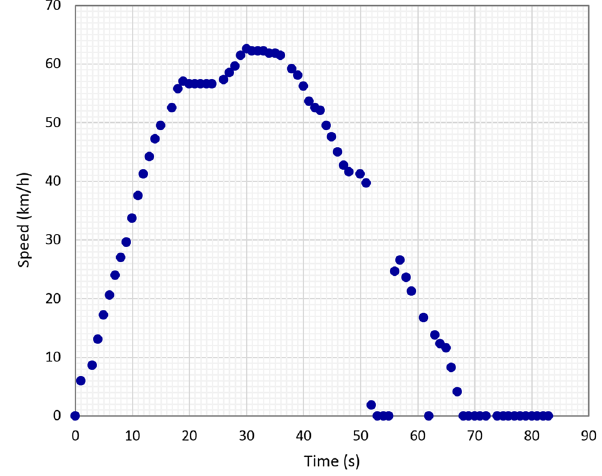
Fig. 5 Wheel slide event circumventing segment